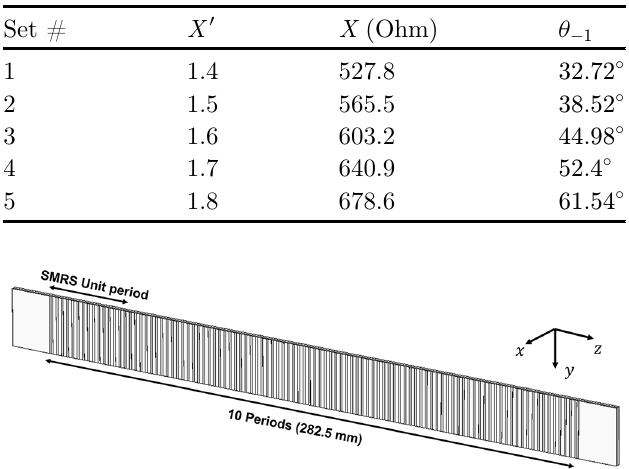
Fig. 7. 3D model of the designed SMRS antenna composed of 10 uniform periods for the EM simulation.